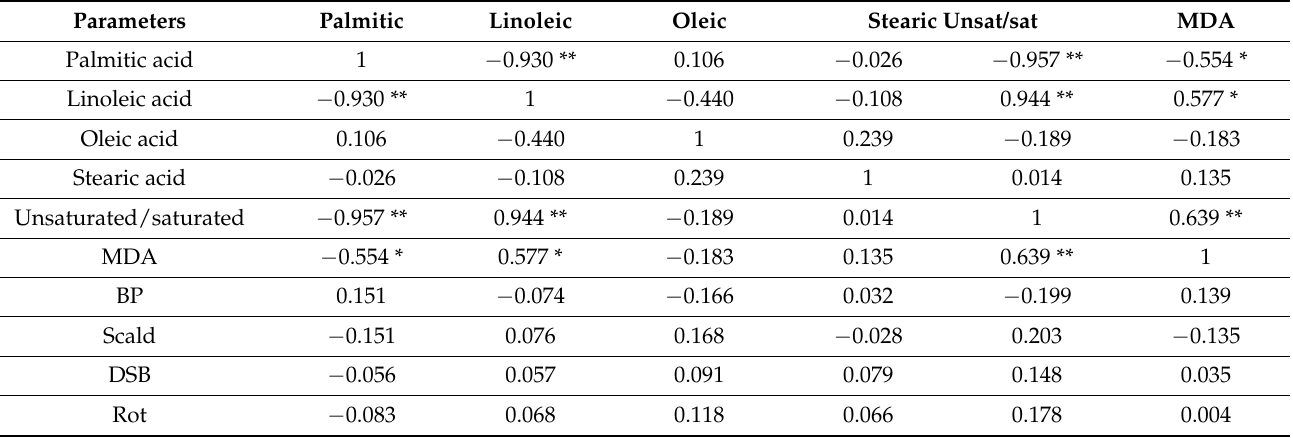
Table 2. Pearson’s correlations among the different fatty acids, unsat/sat ratio, MDA and chilling physiological